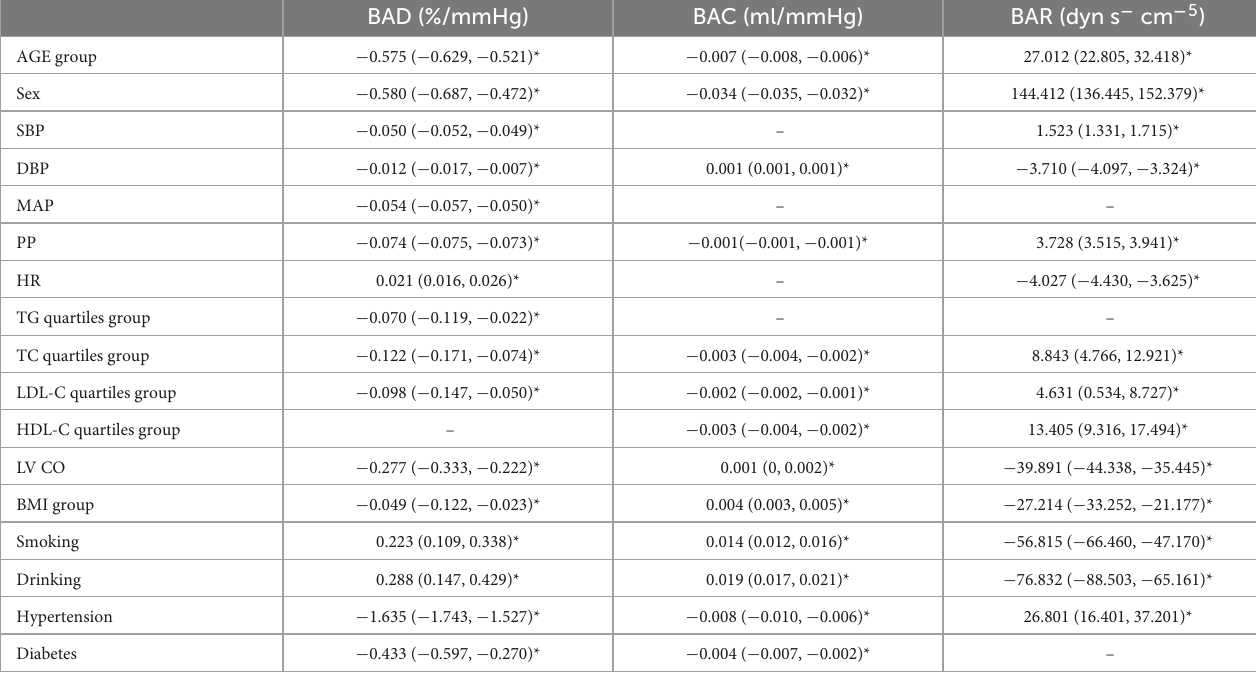
TABLE 3 Univariate analysis of arterial elastic components.